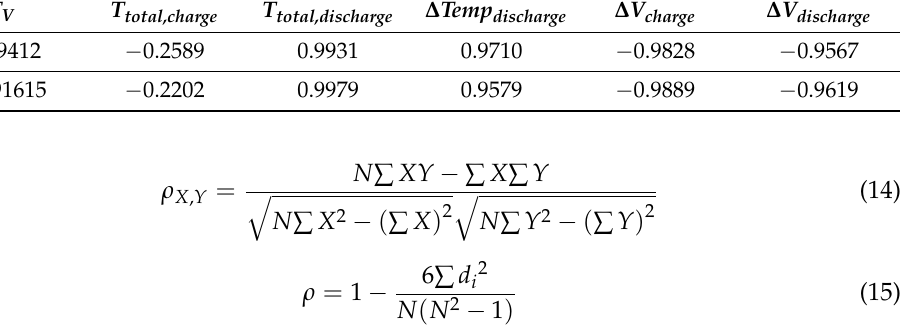
Table 4. Coefficient of Pearson and Spearman.